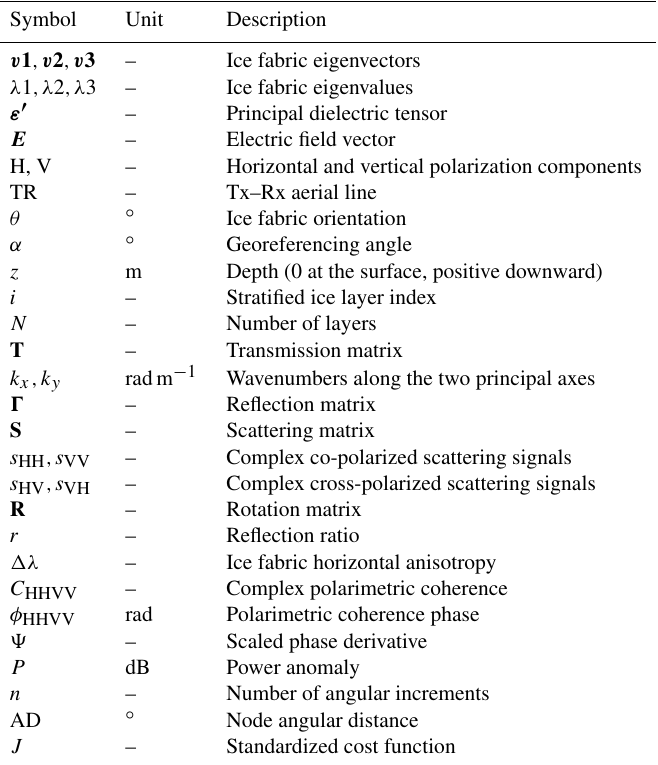
Table 1. Important variables sorted in order of appearance. Symbol